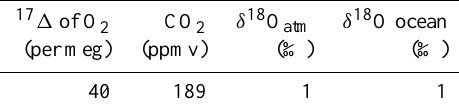
Table 4. Values for the LGM sensitivity study.